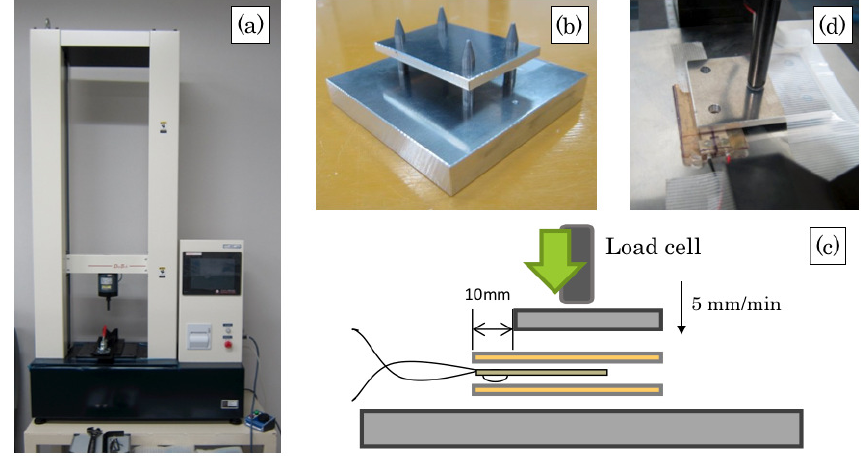
Figure 4. Load test: ( a ) fixture, ( b ) schematic diagram, ( c ) load test, and ( d ) the load test machine (Multi Force Analyzer FWT-1000; DigiTech Co. Ltd., Osaka city,